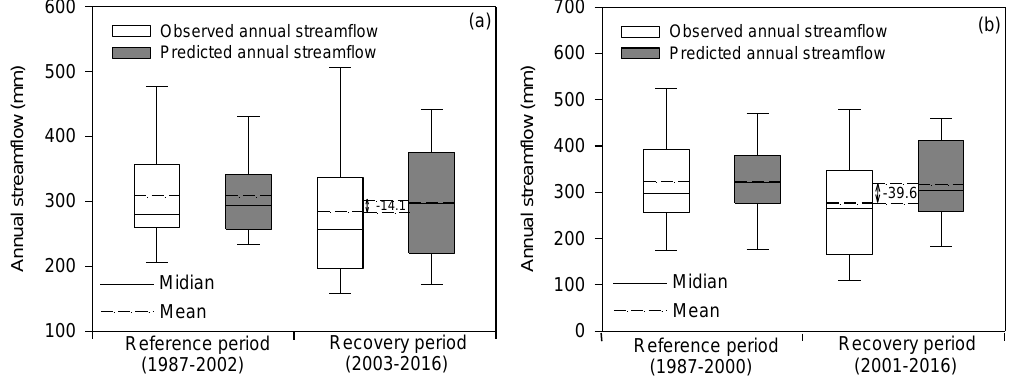
Figure 5. The box plot of observed and predicted annual streamflow calculated by time trend analysis method in: XNC ( a ); and UTH ( b ).